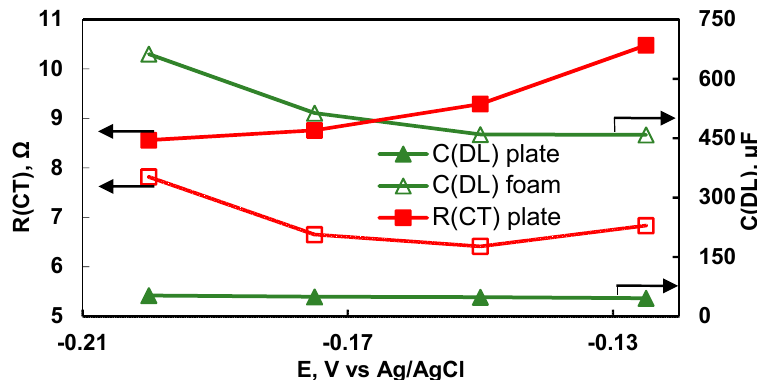
Figure 5. Dependence of double-layer capacitance (ordinate at the right) and charge transfer resistance (ordinate at the left) on potential applied for Cu plate and foam electrodes in 0.1 M CuSO 4 + 0.4 M Na 2 SO 4 solution.